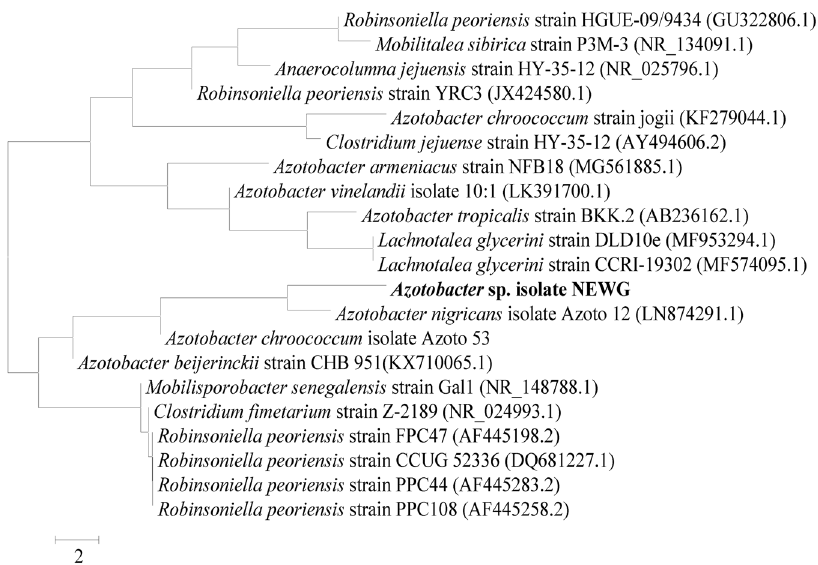
Figure 2. Phylogenetic tree obtained by neighbor-joining analysis showing Azotobacter nigricans NEWG-1 position within the genus Azotobacter